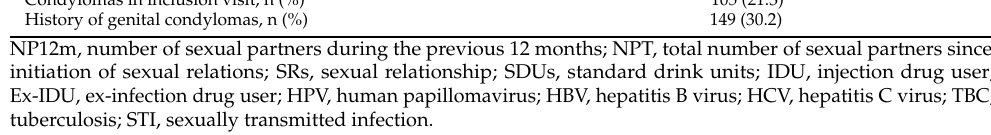
Table 1. Cont. Condylomas in inclusion visit, n (%) History of genital condylomas, n (%)